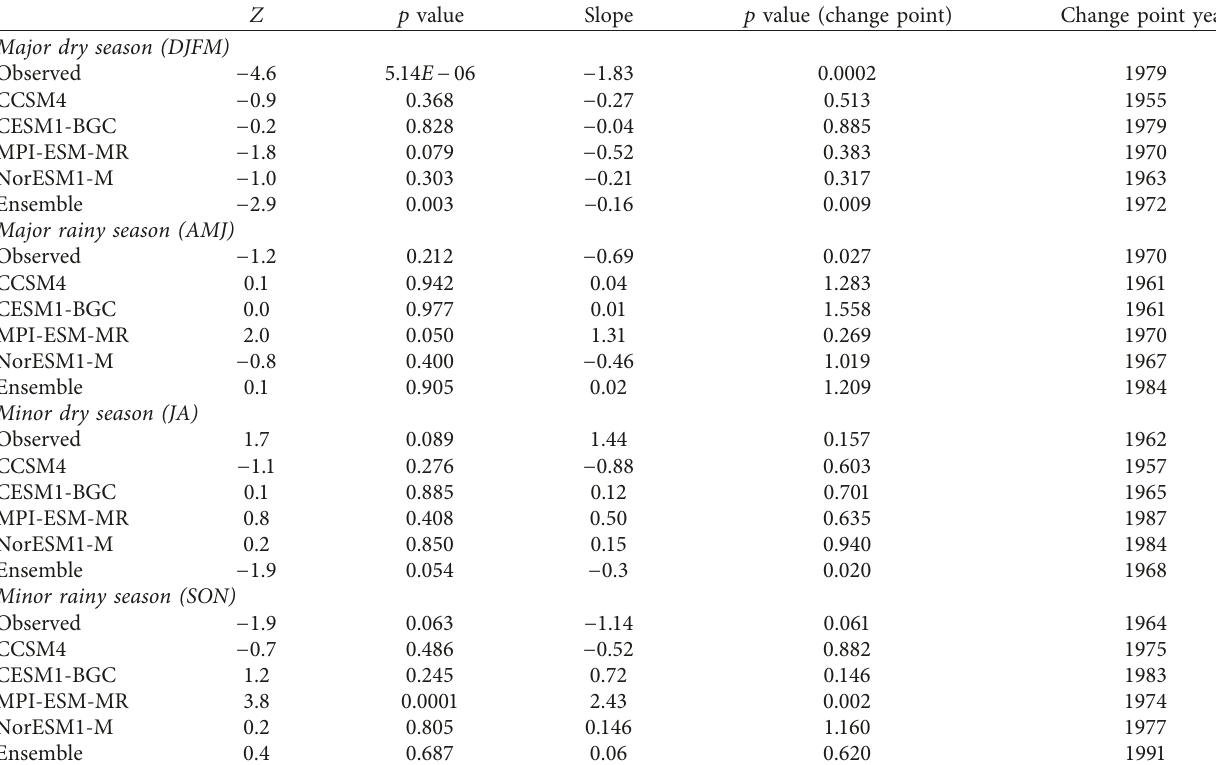
Table 3: Trend test for the Guinea Coast major rainy/dry and minor rainy/dry